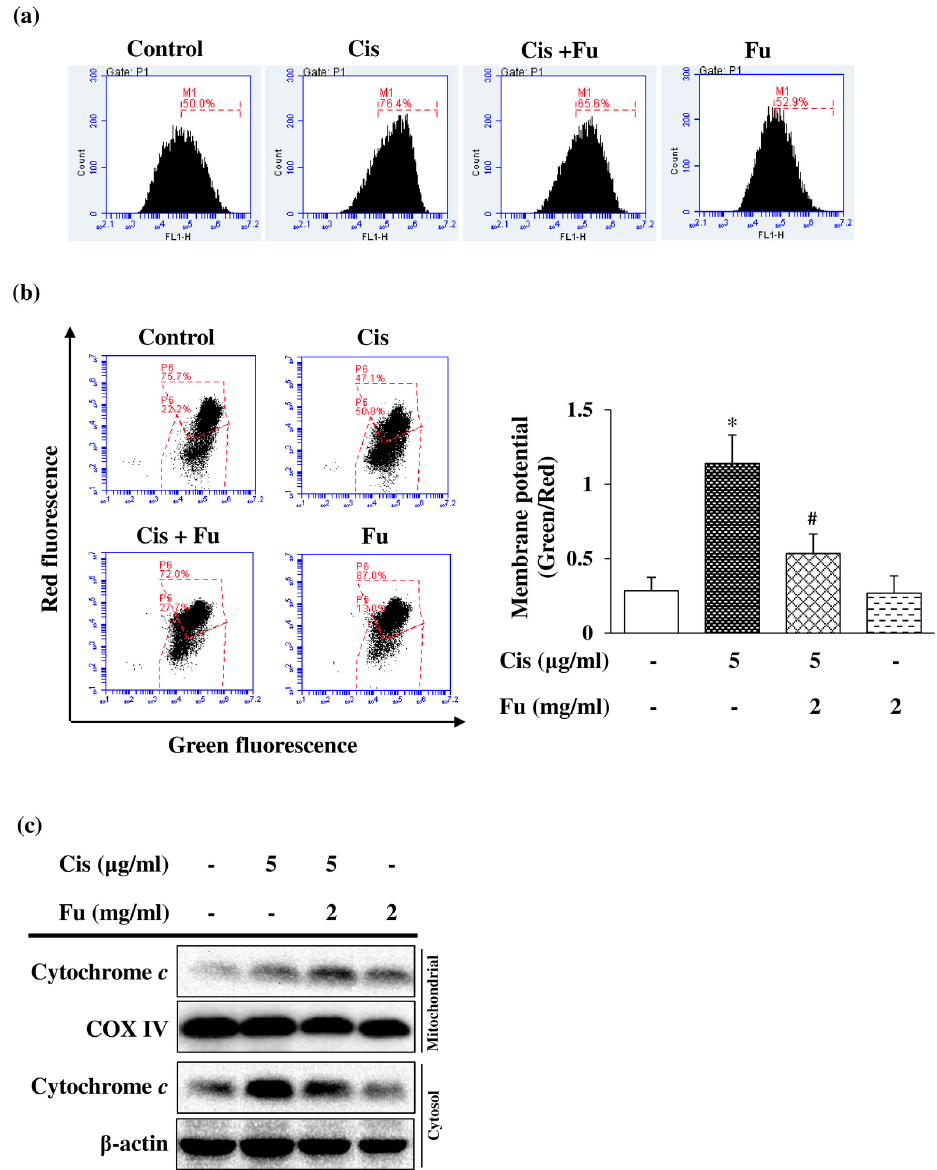
Figure 2. Effects of Fu on Cis-induced ROS production and mitochondrial dysfunction in UB/OC-2 cells. Cells were cultured with Fu (2 mg/mL) for 2 h, followed by stimulation with Cis (5 µ g/mL) for 24 h. ( a ) ROS levels were monitored using the fluorescent dye 2 ′ ,7 ′ -dichlorodihydrofluorescein diacetate via flow cytometry. ( b ) Mitochondrial membrane potential was detected via flow cytometry using the fluorescent dye 5,5 ′ ,6,6 ′ -tetrachloro1,1 ′ ,3,3 ′ -tetramethylbenzimidazolylcarbocyanine iodide. The ratio of the green fluorescence intensity to red fluorescence intensity was quantified. The results are expressed as the mean ± standard deviation. n = 5 per group. * p < 0.05 vs. the control group; # p < 0.05 vs. the Cis group. ( c ) Expression levels of cytochrome c in the mitochondrial and cytosolic fractions were measured using Western blot analysis. COX IV and β -actin were used as internal controls for mitochondrial and cytosolic fractions, respectively. Fu, fucoidan; Cis, cisplatin; ROS, reactive oxygen species; COX IV, cytochrome c oxidase (complex IV). 2.4. Fucoidan Protects against Cisplatin-Induced Apoptosis in Mouse Cochlear UB/OC-2 Cells To elucidate the role of fucoidan in the mitochondrial apoptotic pathway, the expres- sion of the pro-apoptotic protein Bax and the anti-apoptotic protein Bcl-2 was analyzed.